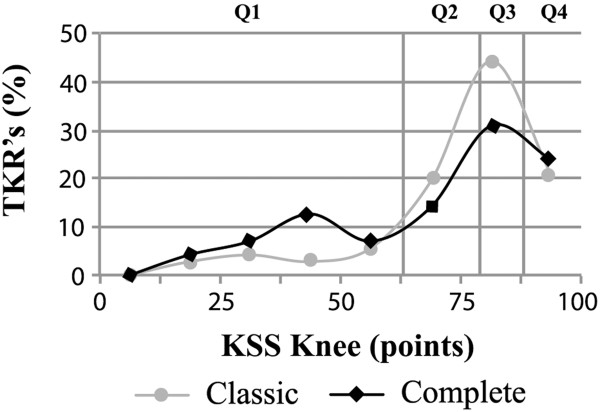
KSS Knee distribution for 'classic’ and 'complete’ TKR. The Y-axis represents the percentage of TKRs of the 'complete’ and 'classic’ cohort. A higher percentage of patients in the 'complete’ cohort is found in the lowest quartile. More specific, 13% of the 'complete’ TKRs score between 37.5 and 50 points compared with 3% of the 'classic’ TKRs. Q1, lowest quartile; Q2, second quartile; Q3, third quartile; Q4, highest quartile.